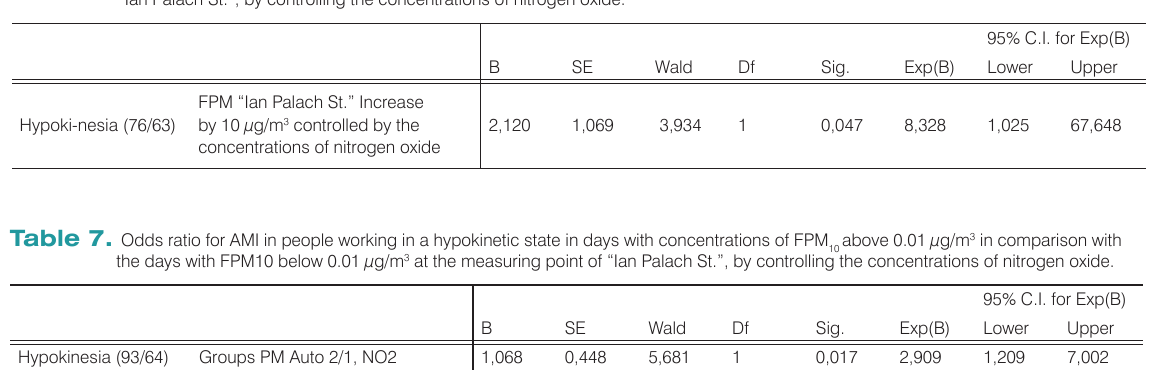
≥ 10 µg/m 3 at the point of 10